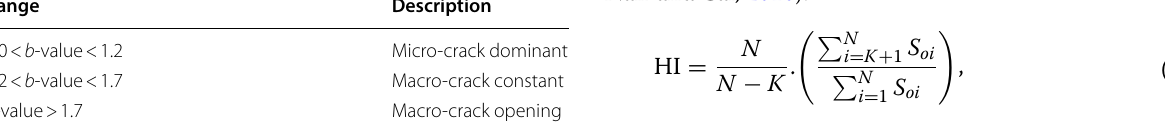
Table 1 The b -value quantitative results (Colombo et al., 2003). Range